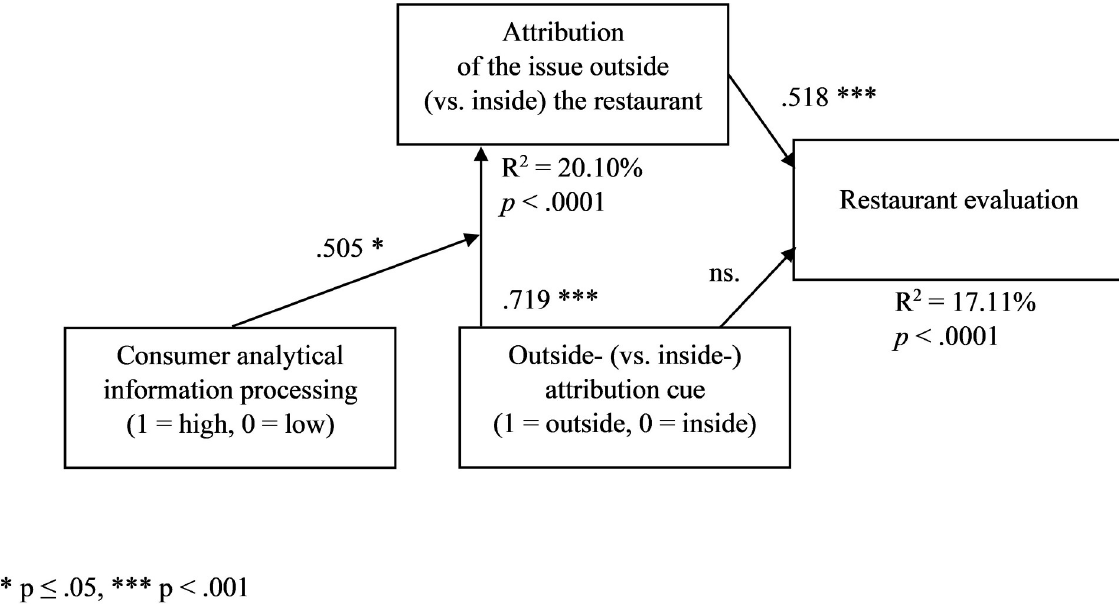
Fig 3. Consumer analytical information processing (manipulated) and the effect of the outside- (vs. inside) attribution cue (manipulated) on the attribution of the issue outside (vs. inside) the restaurant, and restaurant evaluation–a moderated-mediation model (Study 1). The frequency condition is included as a covariate. � p � .05, ��� p < .001.